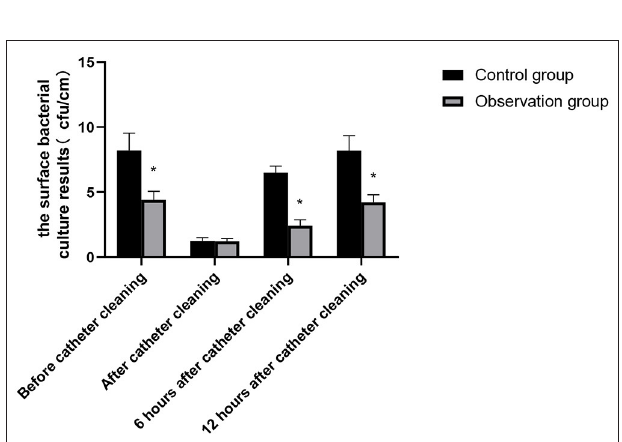
FIGURE 2 | Bacterial culture results on catheter surface of patients in the two groups. Compared with the control group, * p < 0.05.